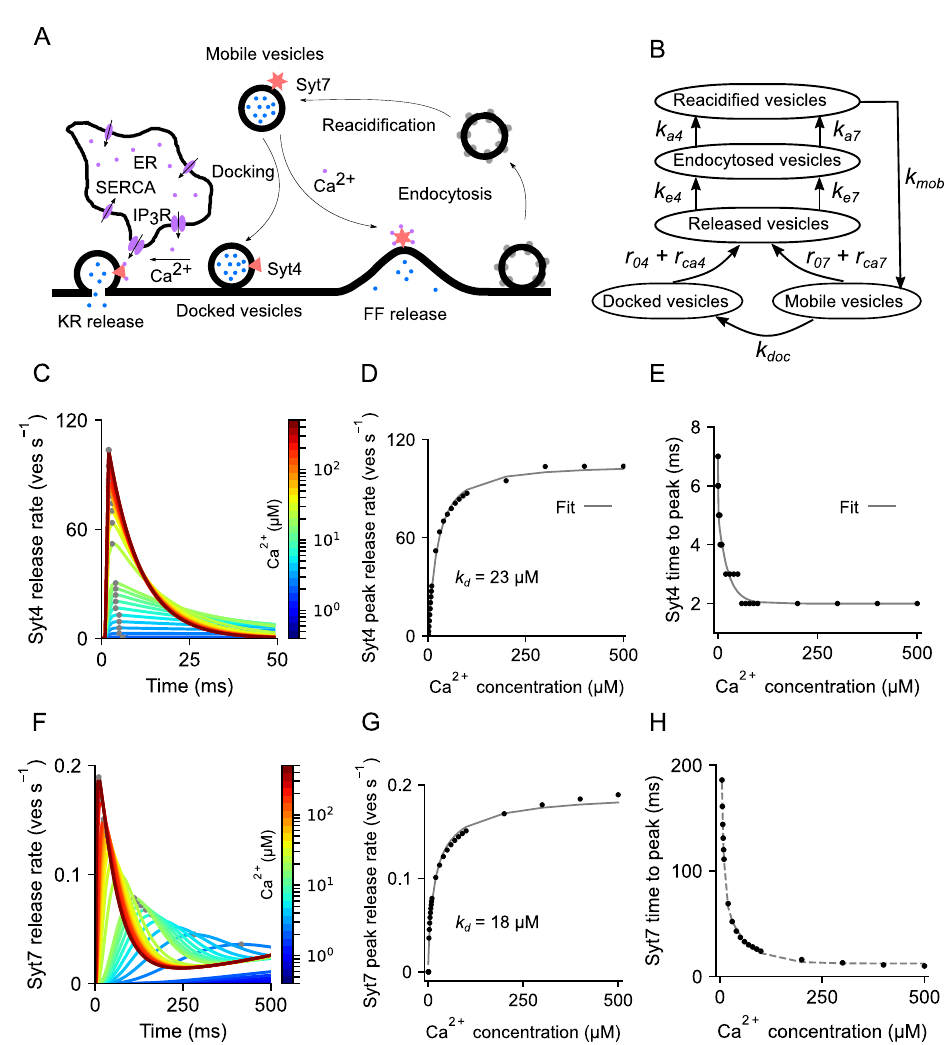
Fig 2. Description and characterization of the Ca 2+ -dependent gliotransmitter release machinery. (A) Schematic of the gliotransmitter release machinery. (B) Pathways of release, endocytosis, and recycling of docked and mobile vesicles. (C) Vesicular release rate through Synaptotagmin 4 ( Syt4 ) in response to a range of steady state Ca 2+ concentrations. (D) Peak release rates of Syt4 are fitted to a Hill function to estimate the dissociation constant ( k Time to peak release rate of Syt4 decays exponentially with Ca 2+ concentration. (F) Release rates of Synaptotagmin 7 ( Syt7 ) in response to a range of steady state Ca 2+ concentrations. (G) Peak release rates of Syt7 . (H) Time to peak release rate of Syt7